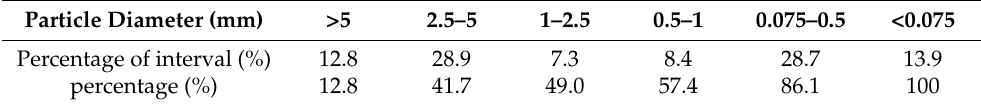
Figure 1. XRD pattern of run-of-mine ore sample. Table 1. Particle gradation of undisturbed rare earth.